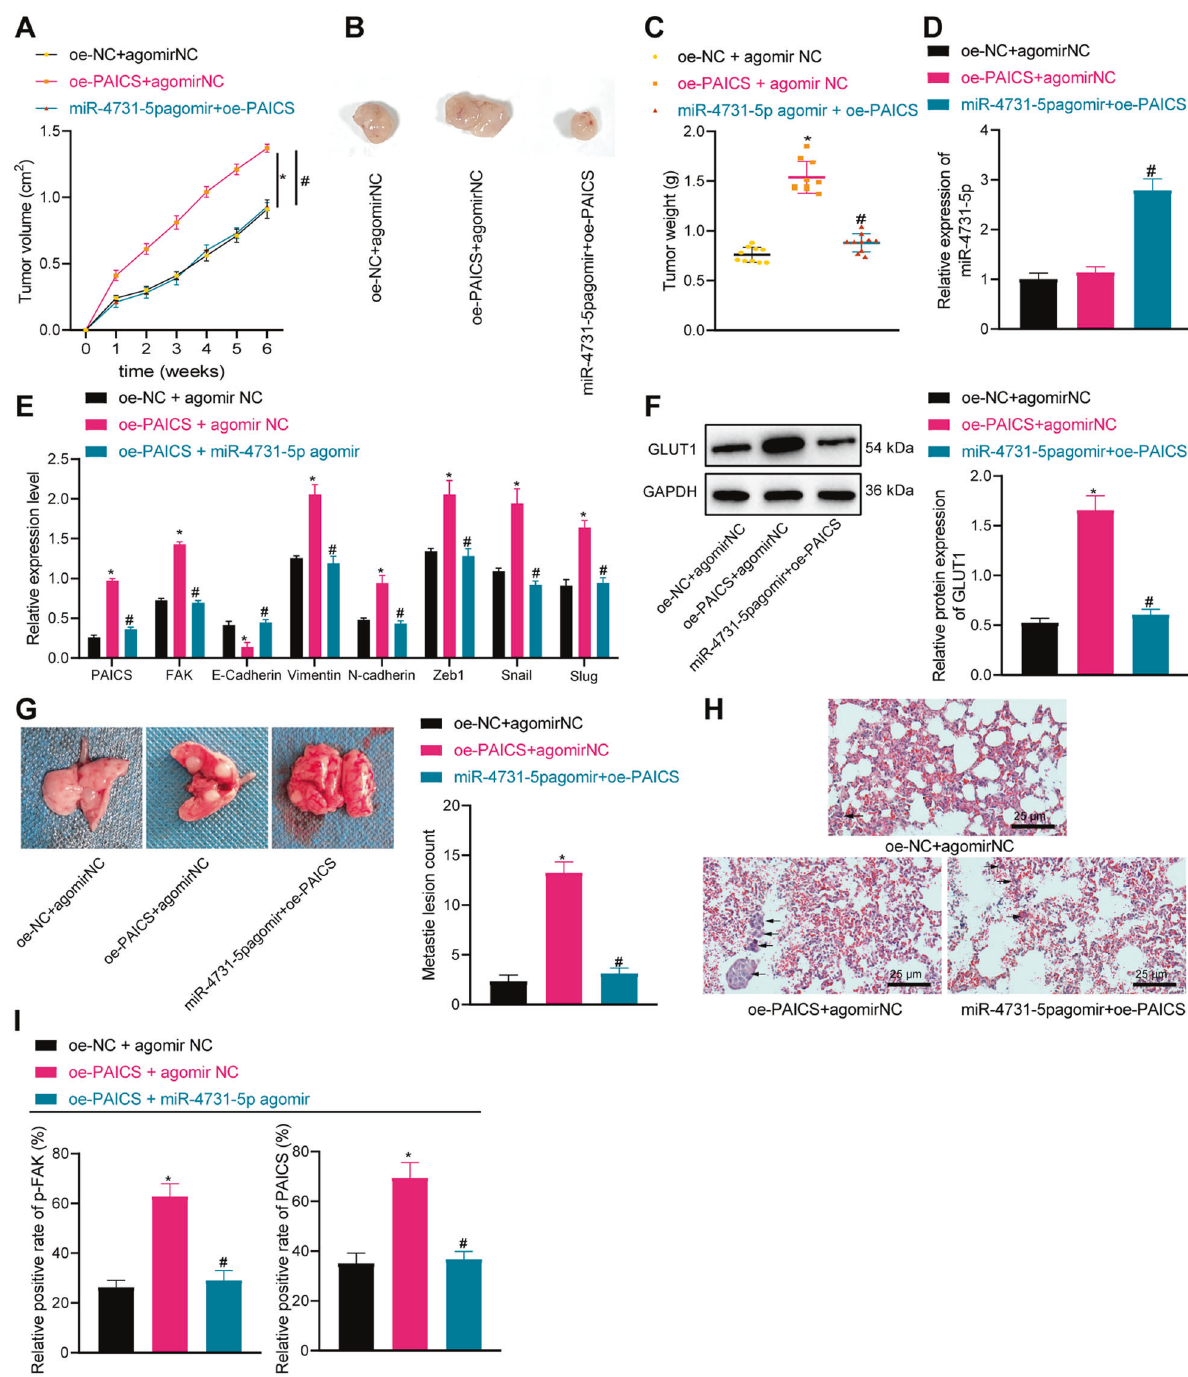
Fig. 7 miR-4731-5p inhibits in vivo tumorigenesis and metastasis in breast cancer through PAICS/p-FAK. A The volume of tumor in nude mice was statistically analyzed. B Representative images of xenograft tumors. C Tumor weight in mice after oe-PAICS and miR-4731-5p agomir treatment. D RT-qPCR was used to detect the expression of miR-4731-5p in tumors after oe-PAICS and miR-4731-5p agomir treatment. E RT- qPCR was used to detect the expression of PAICS, p-FAK, Vimentin, N-cadherin, Zeb1, Snail, Slug, and E-Cadherin. F Western blot analysis was used to detect the expression of GLUT1 in tumors. G The lung and lung tumor metastases in mouse models were observed (the arrow indicates the number of lung metastases). H H&E staining was used to observe the metastasis of lung tissue, scale bar = 25 μ m. I The expression of p-FAK and PAICS in nude mice was detected by immunohistochemistry. Measurement data were expressed as mean ± standard deviation. Analysis among multiple groups was conducted by one-way ANOVA followed by Tukey ’ s post hoc test, n = 10. * p < 0.05 compared with oe-NC + agomir NC treatment. # p < 0.05 compared with oe-PAICS + agomir NC treatment.